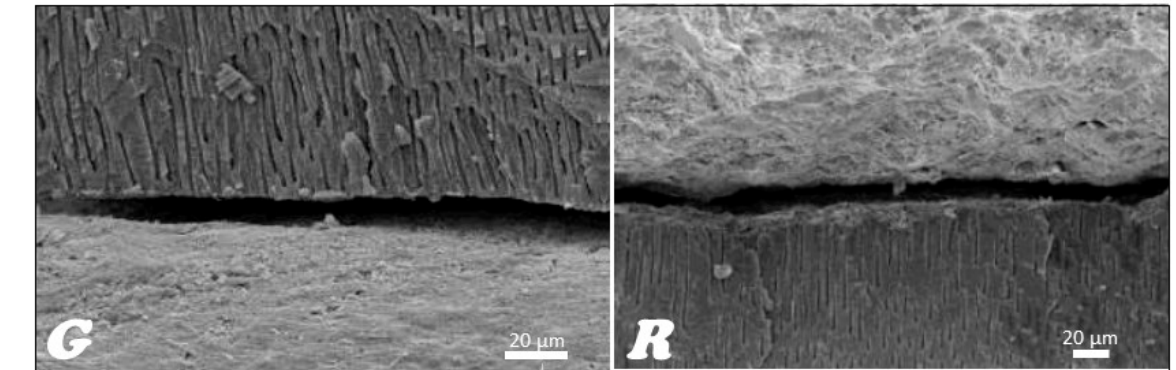
Figure 28. Picture of the leak on the border of the sealant and the dentin of the root canal filled with filling material ( G ) based on hot gutta ‐ percha using the thermoplastic technique THC; ( R ) resilon through cold lateral condensation; SEM.